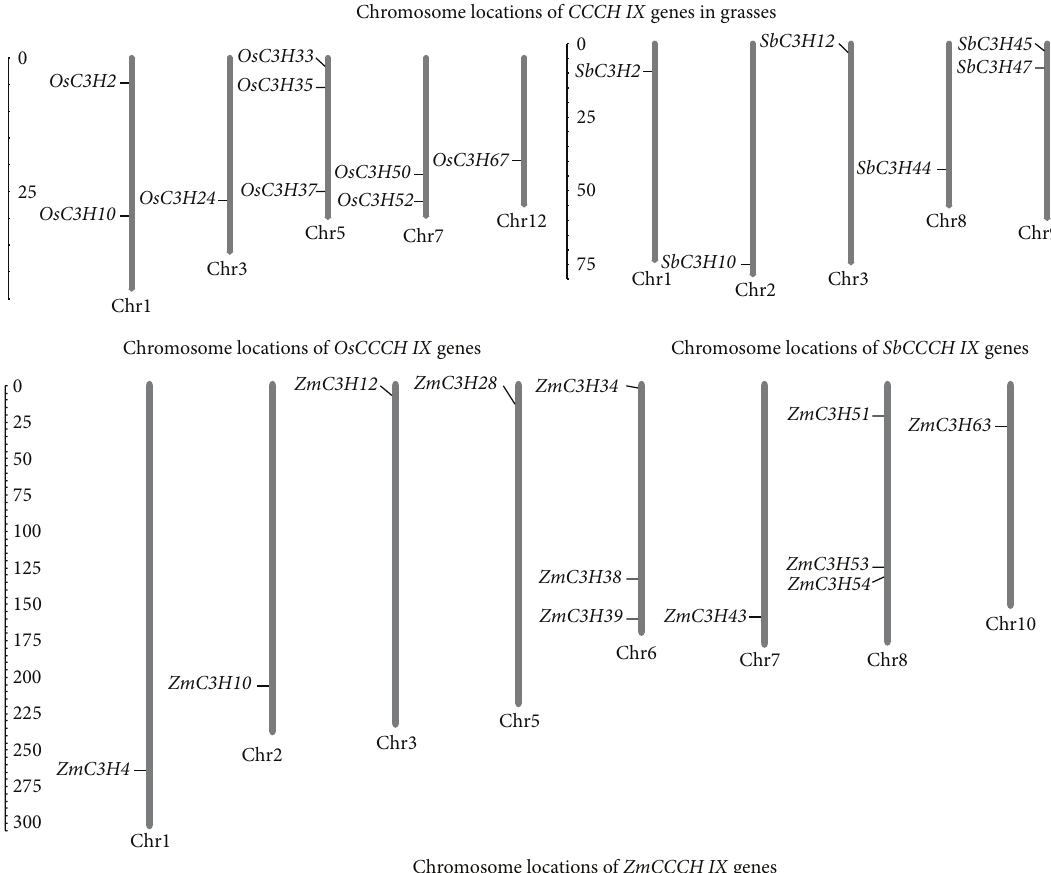
Figure 1: Chromosomal locations of CCCH IX genes in three Gramineae species ( O. sativa , S. bicolor, and Z. mays ). The 27 CCCH IX genes are randomly distributed on chromosomes, including nine rice genes, six sorghum genes, and twelve maize genes.